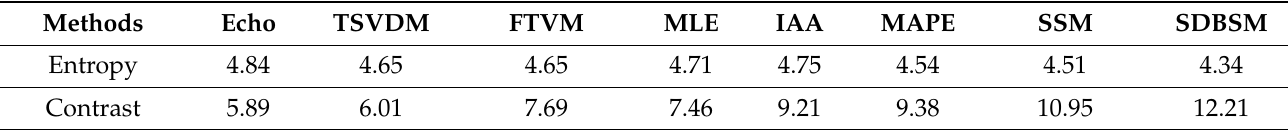
Table 4. Entropy and contrast of the real data